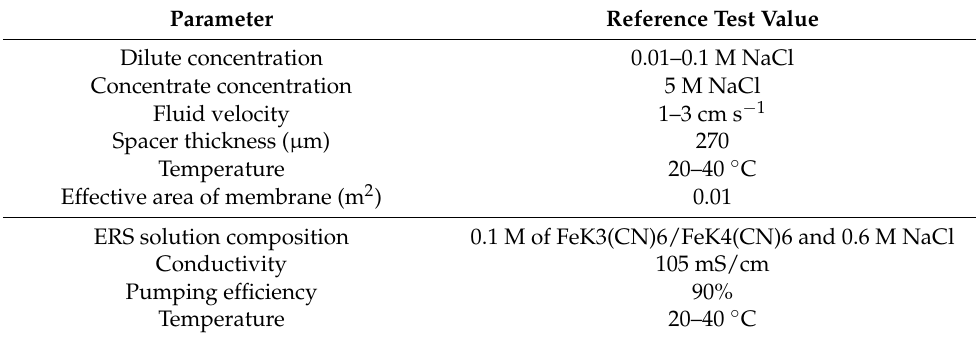
Figure 3. ( A ) Picture of the RED experimental setup. ( B ) shows the RED experimental diagram. HCS: high compartment solution; LCS: low compartment solution; ERS: electrode rinse solution. Table 2. Conditions selected for the